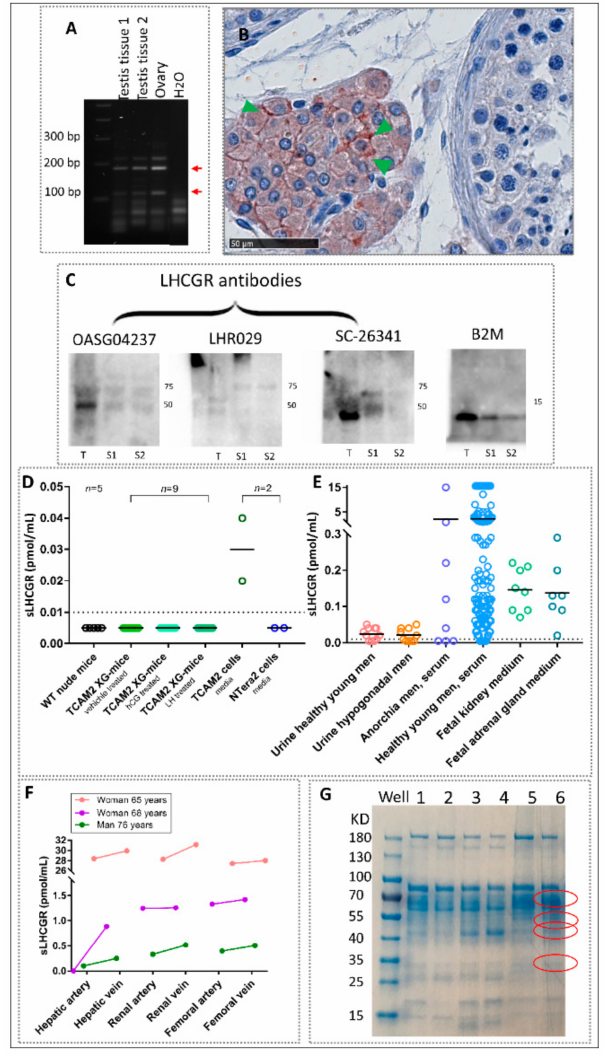
Figure 1. In vitro and baseline analyses of luteinizing hormone receptor (LHCGR). ( A ). Reverse Transcriptase PCR (RT-PCR) with a primer spanning exon 2–4 of LHCGR in two testis tissue and one ovarian tissue sample. Two bands (red arrows) of approximately 100 and 200 bp were sequenced and identified as LHCGR isoforms. ( B ) Immunohistochemistry of human adult testis tissue stained with LHR029 antibody from the ELISA kit showing LHCGR expression in Leydig cells (green arrows). Image is from × 40 magnification ( C ): Western Blot detecting LHCGR with three antibodies targeting different domains examined on testis tissue (T), and in serum from men with high Soluble LHCGR (sLHCGR) level (S1) and low sLHCGR level (S2). ( D ) Human sLHCGR is unmeasurable in serum from WT nude mice, in xenograft (XG) mice implanted with a human seminoma cell line (TCam2), treated with either vehicle, hCG, or LH. sLHCGR is measurable in low levels in media from TCam2 cells but not in a human embryonic carcinoma cell line, NTera2. ( E ) sLHCGR present in urine at comparable levels in healthy and hypogonadal men. sLHCGR measurable in serum from 8 men with both testicles removed at comparable levels as in healthy young men. sLHCGR measurable in media from the cultured human fetal adrenal gland and human fetal kidney. ( F ) Total sLHCGR from arterial- and venous phase across liver, kidney and lower extremity measured in one man and two post-menopausal women shows no significant difference in arterial and venous levels, independent of the organ. ( G ) SDS-protein gel electrophoresis of human serum samples after Immunoglobulin and albumin removal from left well 1–6: serum from 2 normal men, 1 man with testicular germ cell cancer, seminoma, 1 man with testicular germ cell cancer, non-seminoma, and 2 pregnant women. Four bands of approximately 35, 50, 60, and 75 kDa from the pregnant woman in well number 6 were analyzed by